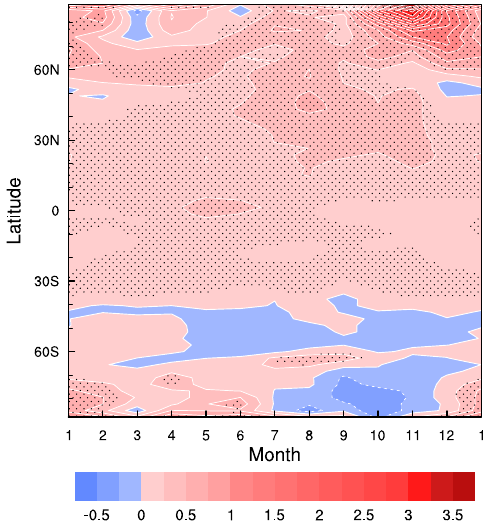
Fig. 11. Latitude-month plots of zonal-mean SAT trend differ- ences between AR4-O 3 and AR4-NO-O 3 models over 2001–2050. Colour interval is 0.25K per 50yr, pink: positive, and blue: nega- tive.